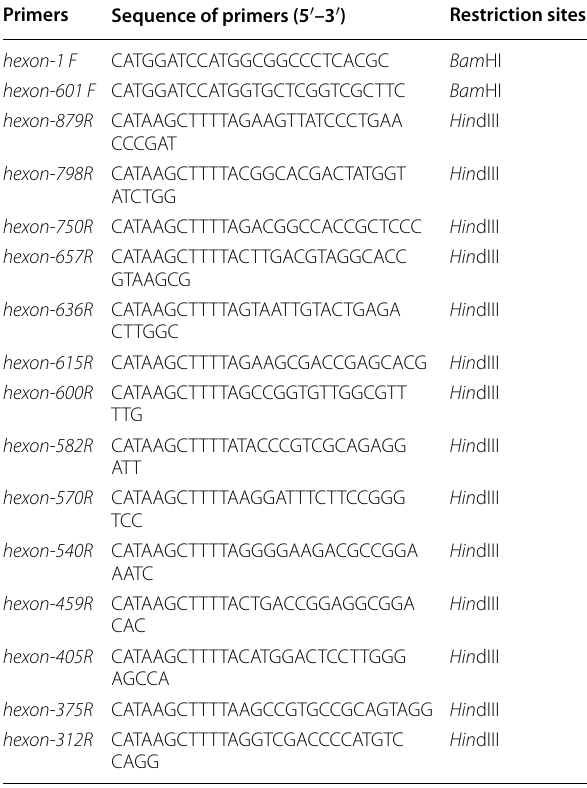
Table 1 Primers for full-length and truncated fragments of hexon Primers Sequence of primers (5 ′ –3 ′ ) Restriction